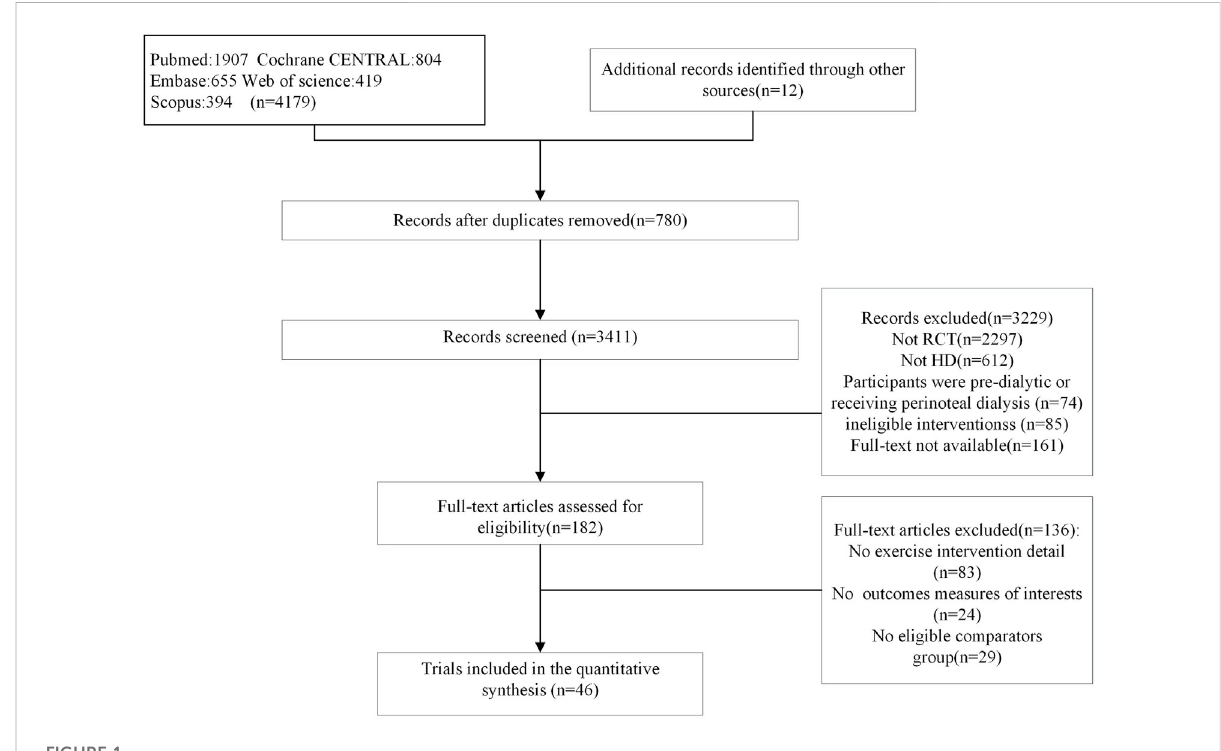
FIGURE 1 Flow of studies through the